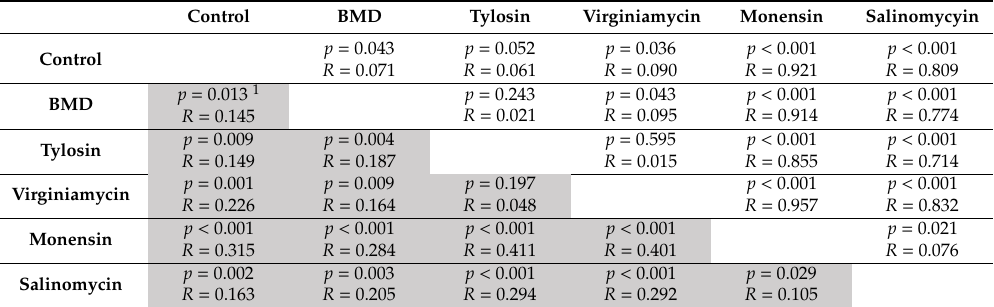
1 Shaded p - and R-values are for the Bray-Curtis index, while non-shaded p - and R-values represent the Jaccard index.